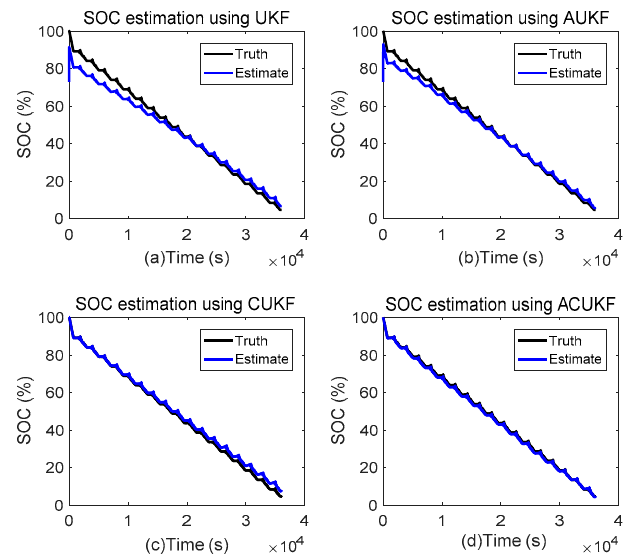
Figure 9. SOC estimate comparison using different methods under shot noise. ( a ) SOC estimation using UKF; ( b ) SOC estimation using AUKF; ( c ) SOC estimation using CUKF; ( d ) SOC estimation using ACUKF.